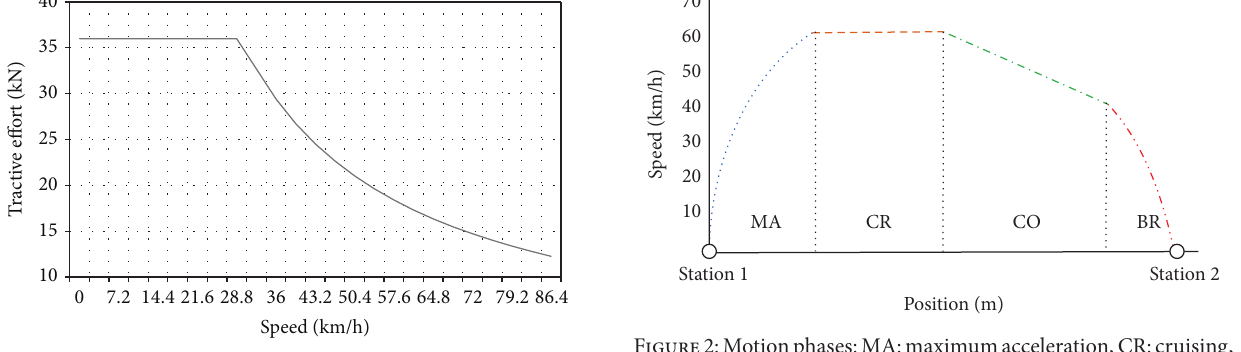
Figure 1: Tractive effort, speed graph for a tram with power 571 hp.